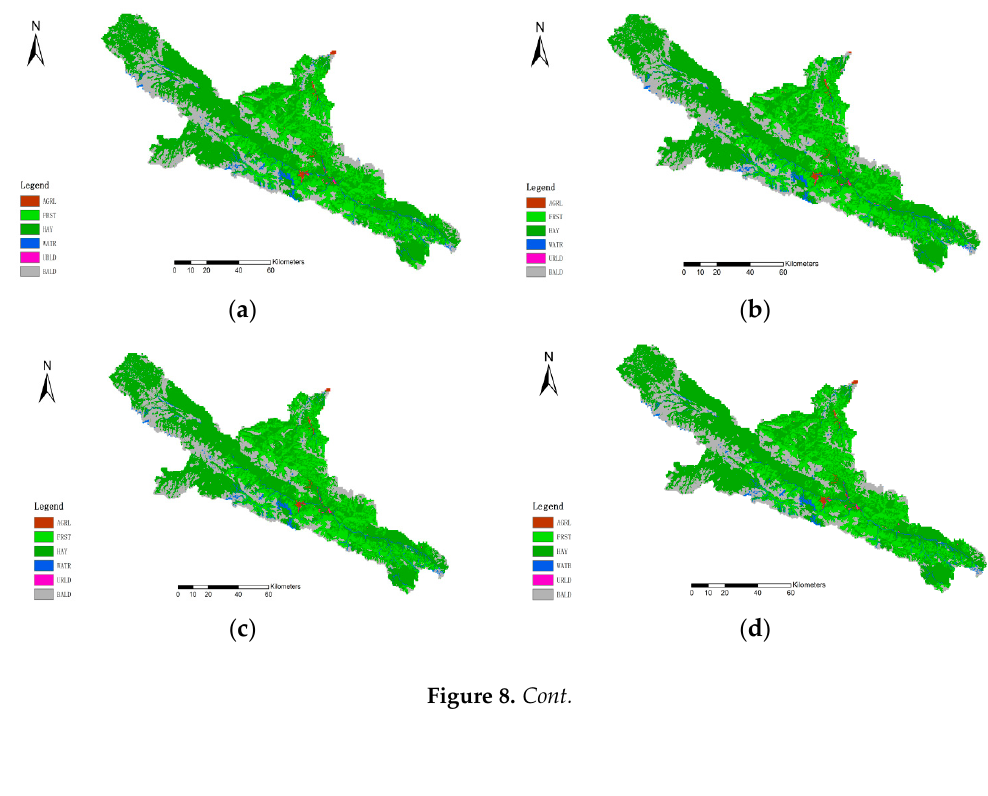
Table 12. Response of runoff to temperature increase and precipitation